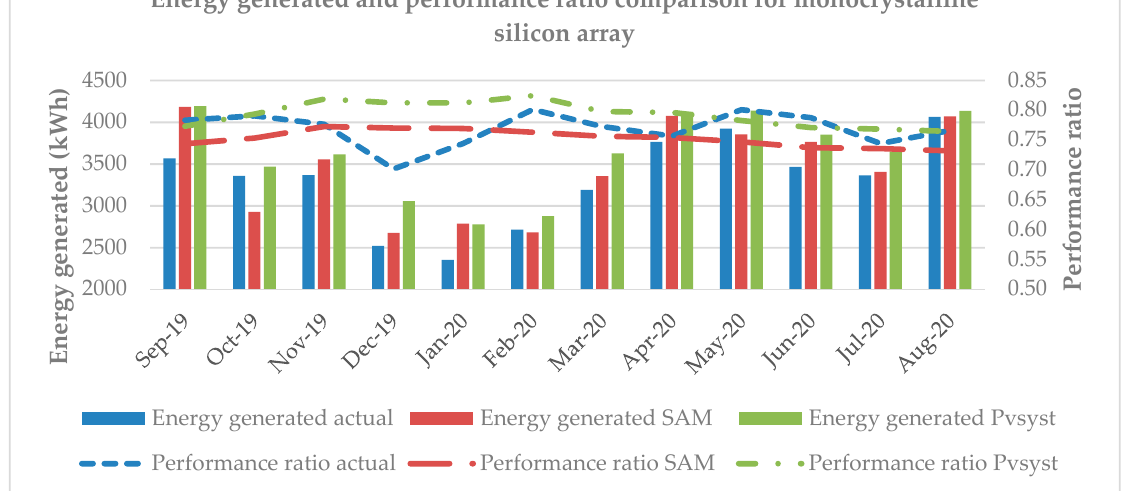
Figure 16. Comparison of actual energy generated and performance ratio to simulated values for monocrystalline silicon array.